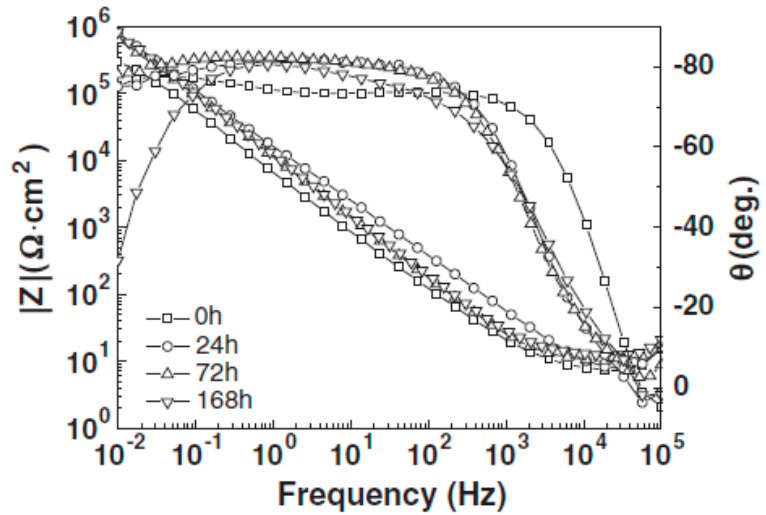
Figure 2. Electrochemical impedance spectroscopy (EIS) spectra of Ti-24Nb-4Zr-8Sn alloy at different immersion hours in 0.9% NaCl solution [43].